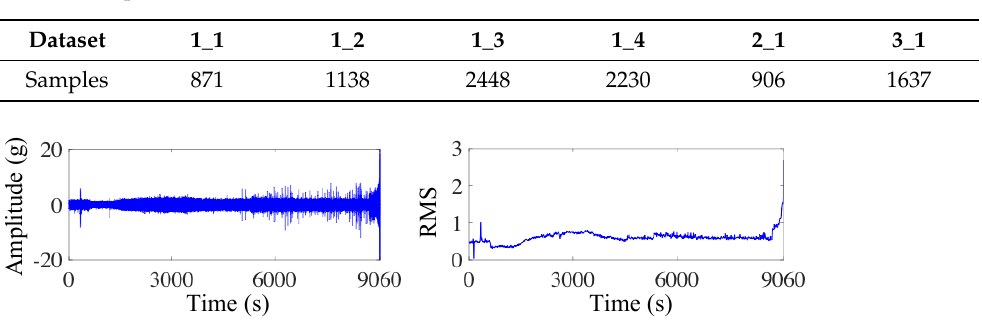
Table 2. Sample number of each dataset.